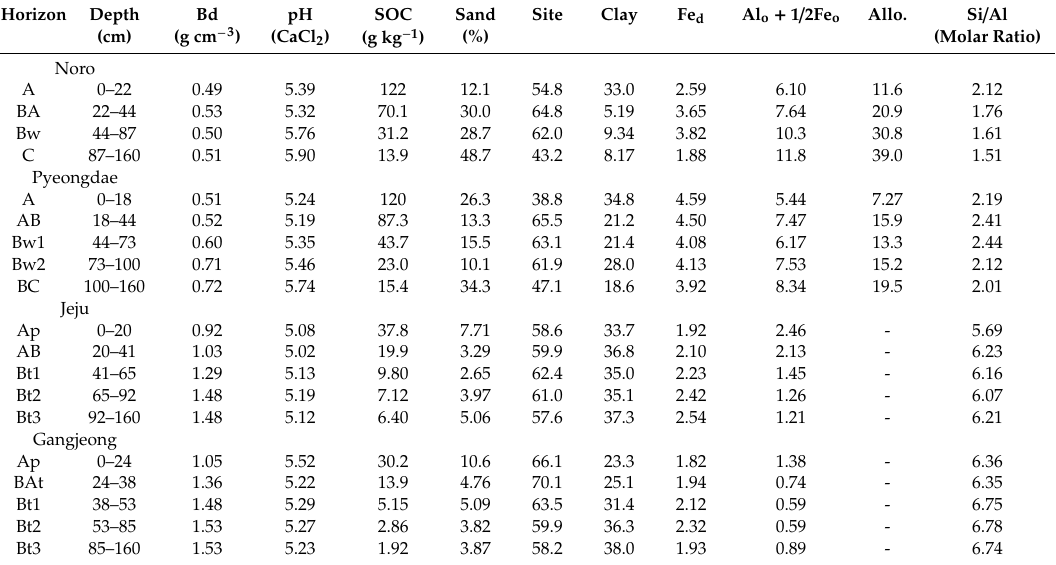
Table 2. Physical and chemical properties of the soils studied in Jeju Island (Noro, Pyeongdae, Jeju, and Gangjeong) and mainland Korea (Samgag and